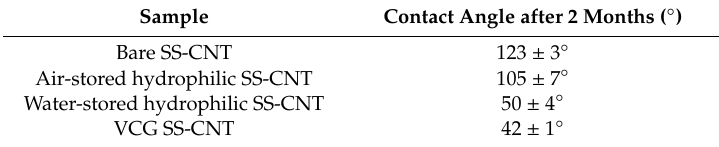
Figure 2. Contact angle aging of Photo-initiated chemical vapor deposition (PICVD) treatment on SS-CNT (carbon nanotube forest on stainless steel grids) samples. Table 3. Water contact angle after 2 months. SS-CNT: carbon nanotube forest on stainless steel